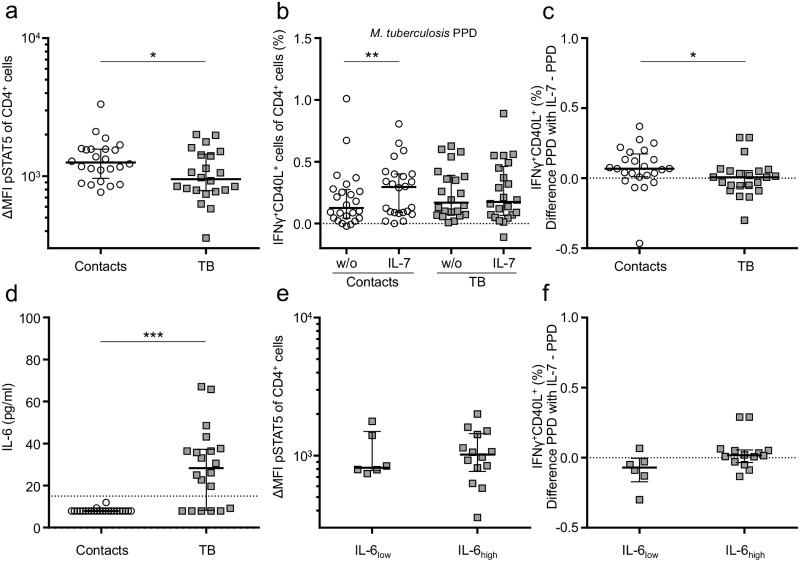
IL-7 response of CD4+ T cells from tuberculosis patients and healthy contacts.(a) IL-7-induced (10 ng/ml) STAT5 phosphorylation of CD4+ T cells from tuberculosis patients (n = 22) and healthy contacts (n = 24) measured by flow cytometry. The STAT5 phosphorylation level of non-stimulated cells has been subtracted of all values. (b) IFNγ/CD40L-expressing CD4+ T cells after PPD re-stimulation in the presence or absence of IL-7 detected by flow cytometry. Non-stimulated values with or without IL-7 have been subtracted. (c) Induction of IFNγ/CD40L-expressing CD4+ T cells by IL-7 and PPD stimulation. Absolute differences as compared to PPD alone are shown. (d) Plasma IL-6 levels of tuberculosis patients (n = 20) and healthy contacts (n = 24). An arbitrary threshold indicated by a dotted line was set to define tuberculosis patients with high (IL-6high) and low (IL-6low) concentrations of plasma IL-6. (e) STAT5 phosphorylation, and IL-7-induced PPD response (f) for tuberculosis patients with high or low plasma IL-6 level, as defined in (d). Median and interquartile range is depicted, and exact Mann-Whitney U test was applied for comparison of groups, whereas paired data was evaluated by Wilcoxon Signed-Rank test. Nominal p-values are indicated as * p < 0.05, ** p < 0.01, *** p < 0.001.